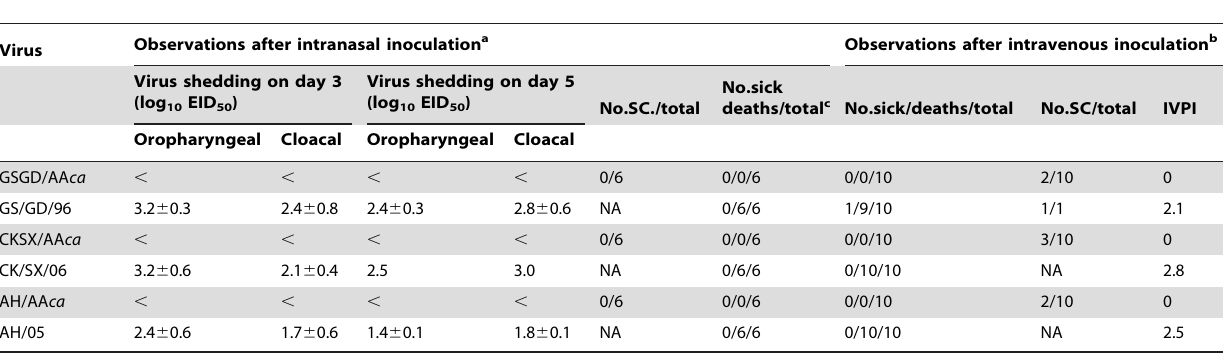
Table 1. Attenuation phenotype of the recombinant AH/AA ca virus in chickens.